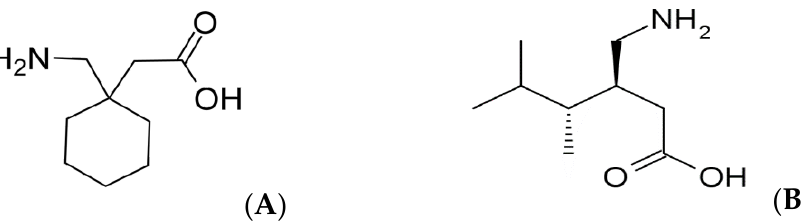
Figure 1. ( A , B ): Chemical structures of gabapentin ( A ), and the internal standard pregabalin ( B ).